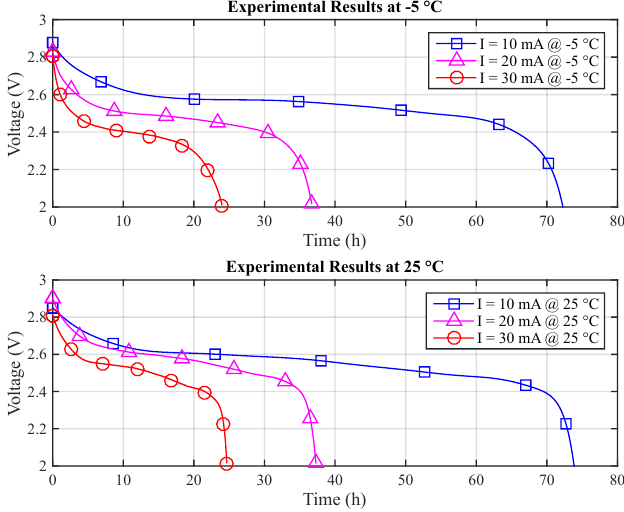
Figure 6. Experimental results at different